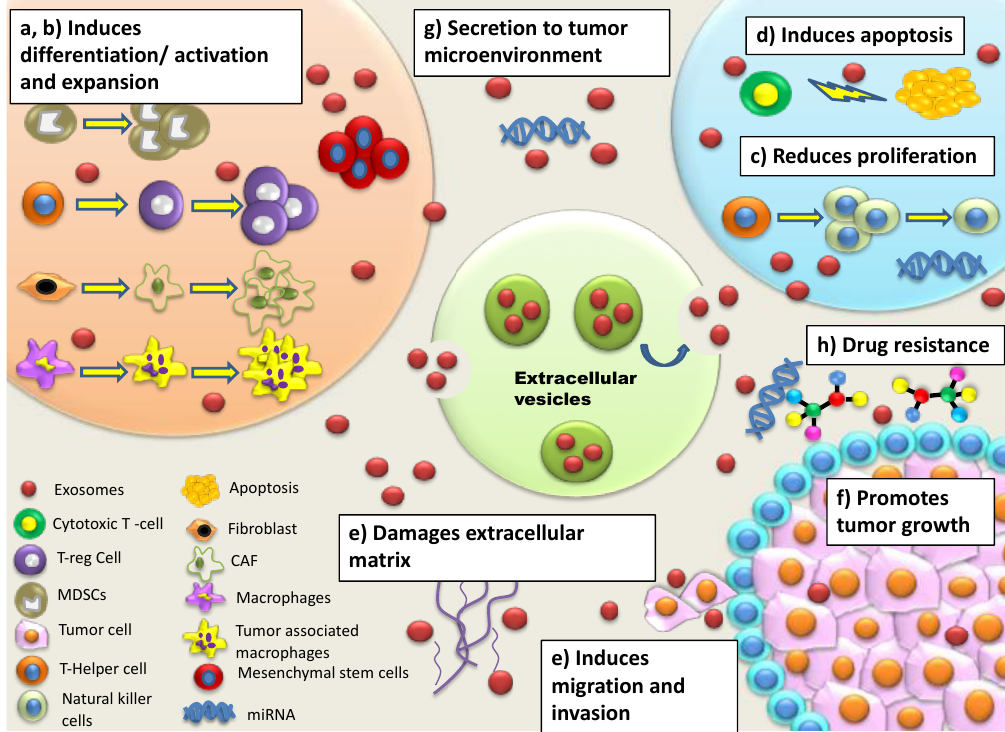
Figure 1. Re-modeling of tumor microenvironment by EVs in CRC. EVs are associated with inducing re-modelling of the tumor microenvironment to promote tumor progression via mechanisms including; ( a ) differentiation of macrophages, stromal fibroblasts etc., ( b ) secretion of cytokines/chemokines to induce expansion of regulatory cells such as Tregs, myeloid derived secreted cells (MDSCs), ( c ) reducing proliferation of natural killer cells (NK cells), ( d ) inducing apoptosis of cytotoxic T-cell (CD8+), ( e ) damaging extracellular matrix to promote cell migration and invasion, ( f ) inducing phenotypic changes, ( g ) secreting non-coding RNAs, ( h ) promoting drug resistance.